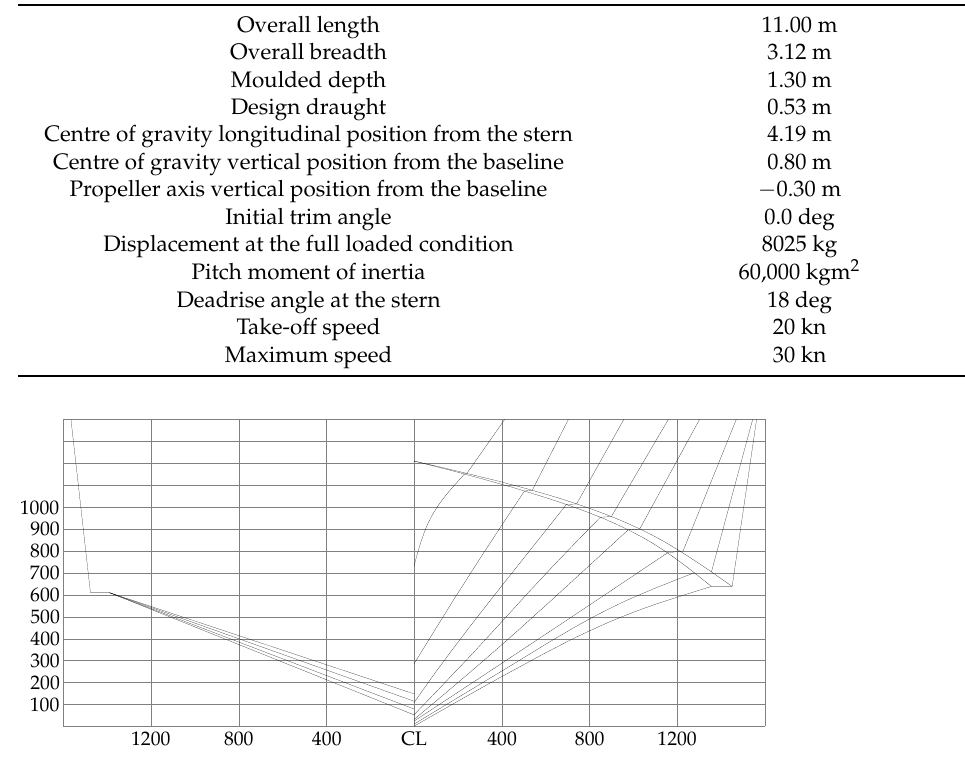
Figure 3. Section lines of the USV01 craft (all dimensions are in mm).